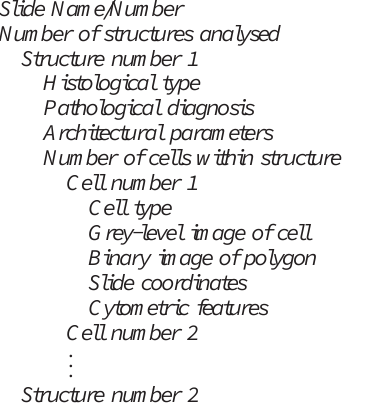
Table 1 Information from the analysis of each slide is stored